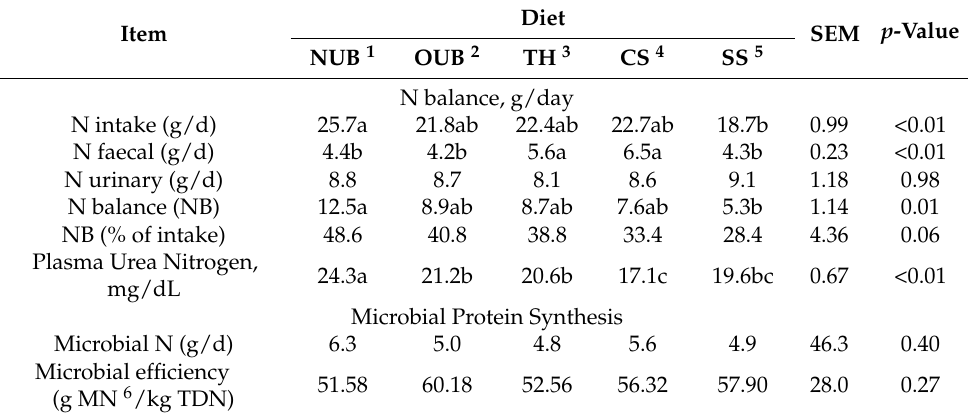
Table 5. Nitrogen balance (N), urea nitrogen concentration, and microbial protein synthesis for sheep fed different